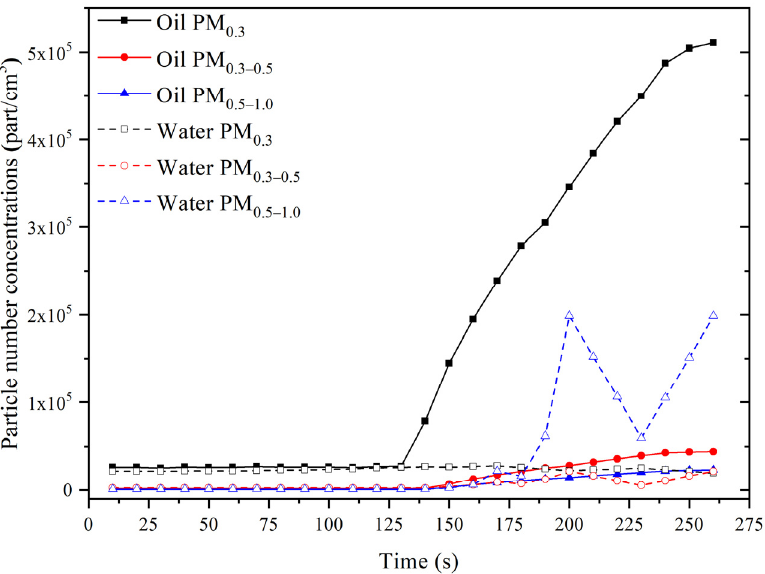
Figure 2. Comparison of changes in particle number concentrations when heating water and corn oil.